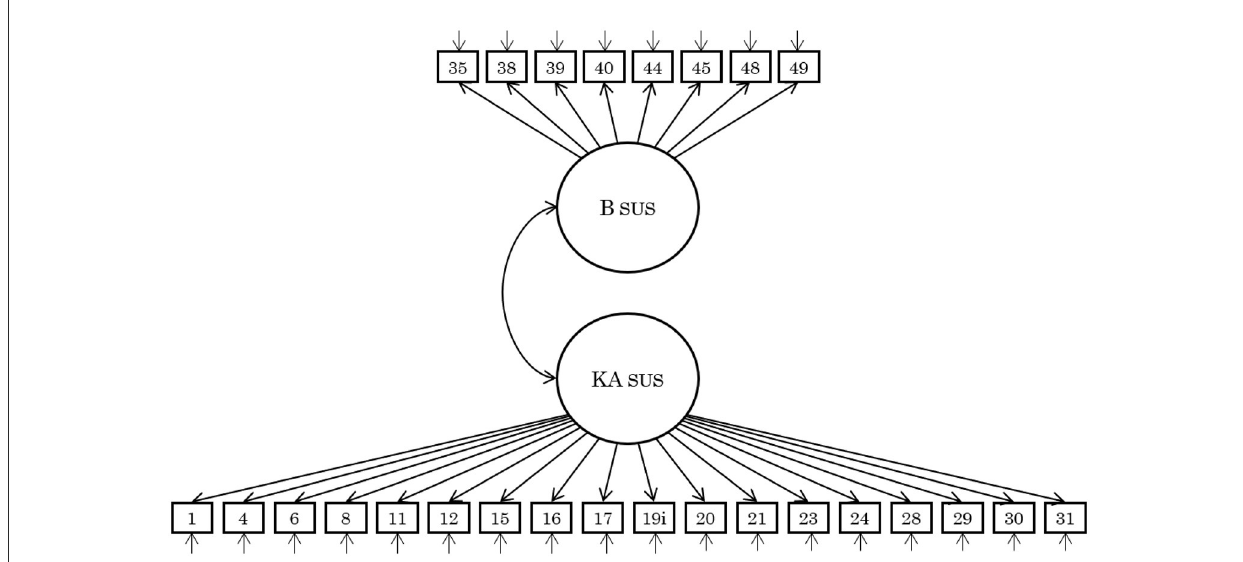
FIGURE5 A model of the Japanese version of sustainability consciousness questionnaire. The number in squares indicates the item number of the SCQ (see Supplementary Table 1 for details). Measurement errors are omitted from the notation. Correlated errors were assumed with each domain (i.e., economics, social, environmental). KA, knowingness/attitude; B,